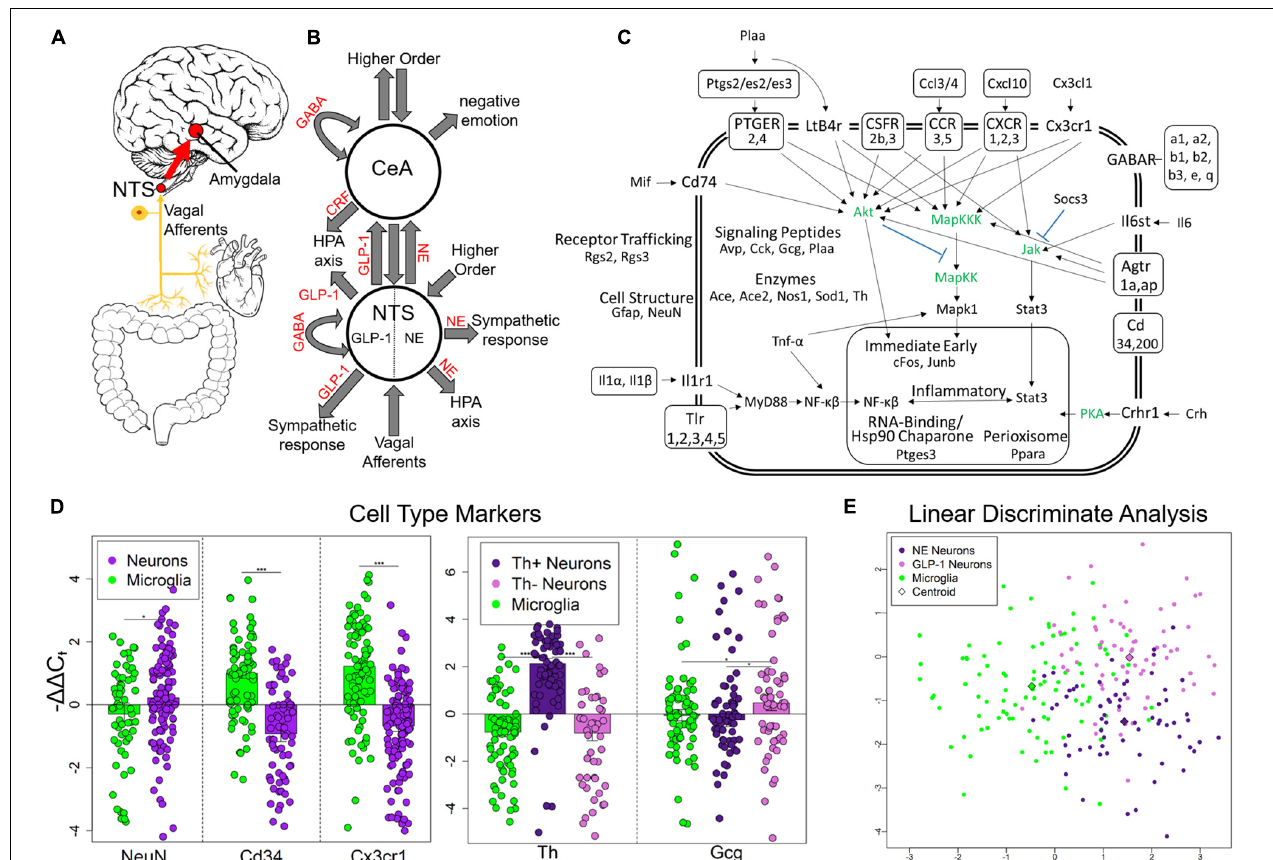
FIGURE 1 | Experimental design and single-cell selection. (A) Nucleus tractus solitarius (NTS) is primary viscerosensory nucleus of brain that relays inputs to limbic system via the central nucleus of the amygdala (CeA). Originally published in O’Sullivan and Schwaber (2021). (B) Diagram displaying NTS and CeA functions in emotion, stress, and autonomic regulation. NTS GLP-1 and NE neurons are highlighted. Many anatomical and functional connections are omitted for clarity (NE, norepinephrine; GLP-1, glucagon-like peptide 1; GABA, γ -aminobutyric acid; HPA axis, hypothalamic-pituitary-adrenal axis; CRF, corticotropin releasing hormone). Originally published in O’Sullivan and Schwaber (2021). (C) Cell diagram displaying genes assayed and their function. Genes in green were not assayed. Official gene symbol is used. (D) Gene expression of cell type markers. Error bars show standard error. Neurons compared to microglia p -values = 0.0273, 3.94E-10, 7.73E-12, respectively. Th + neurons showed elevated Th expression compared to Th − neurons ( p = 4.56E-11) and microglia ( p = 2.95678E-15). Th − neurons showed elevated expression of Gcg compared to Th + neurons ( p = 0.0106) and microglia ( p = 0.0435) indicating they are GLP-1 + neurons. * p < 0.05, *** p < 4E-10. (E) Linear discriminate analysis of all samples displays the difference across all genes measured between the three cell types collected in a two-dimension space. Centroid distance between NE neurons and GLP-1 neurons = 3.30, NE neurons and microglia = 1.57, GLP-1 Neurons and microglia: 2.92.